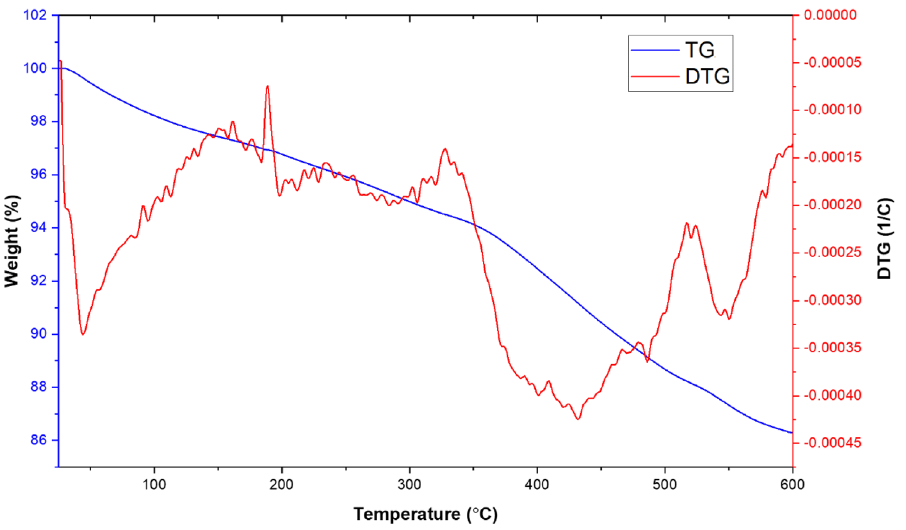
Figure 7. TGA and DTG analysis of Fe 3 O 4